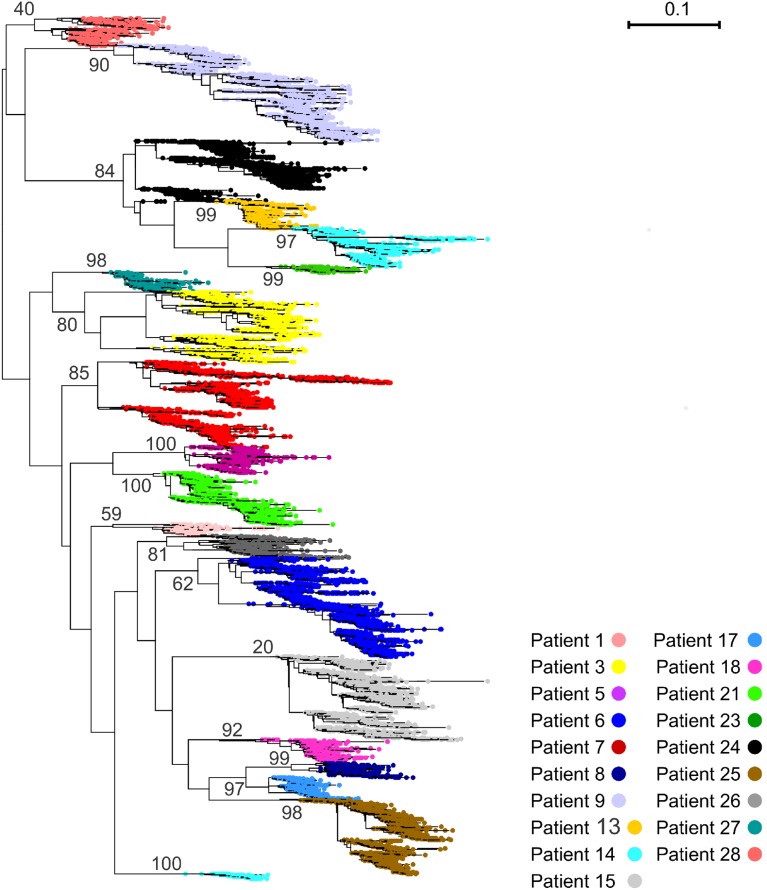
Maximum likelihood phylogenetic tree of C2-V3-C3 nucleotide sequences from patients included in the study.Patient-related clusters are identified in different colors as indicated at the bottom of the figure. The vertical size of the clusters is proportional to the number of reads in the cluster and the horizontal size of the clusters shows their maximum genetic depth. Bootstrap values are given on branches. Branch lengths are proportional to the number of nucleotide substitutions per aligned site (bar = 0.1 substitutions).